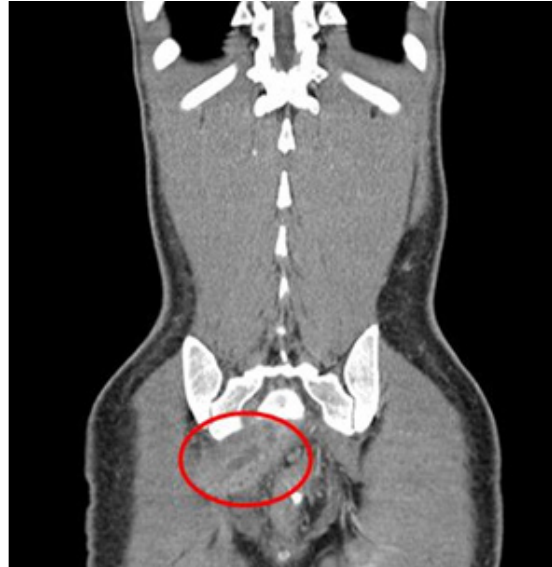
Figure 2. Coronal reformat better demonstrating the oblique, presacral course of the sinus tract along the piriformis